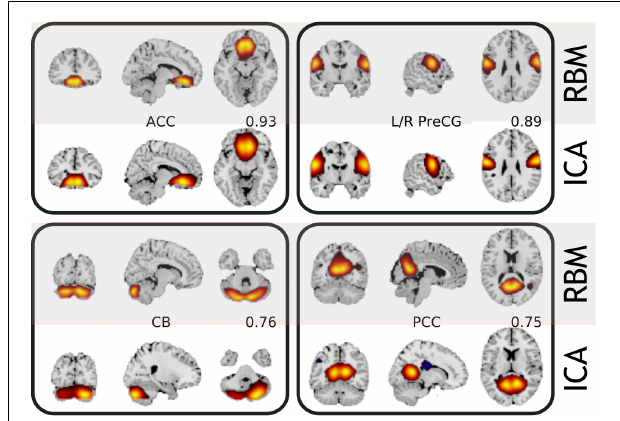
FIGURE 3 | Intrinsic brain networks estimated by ICA and